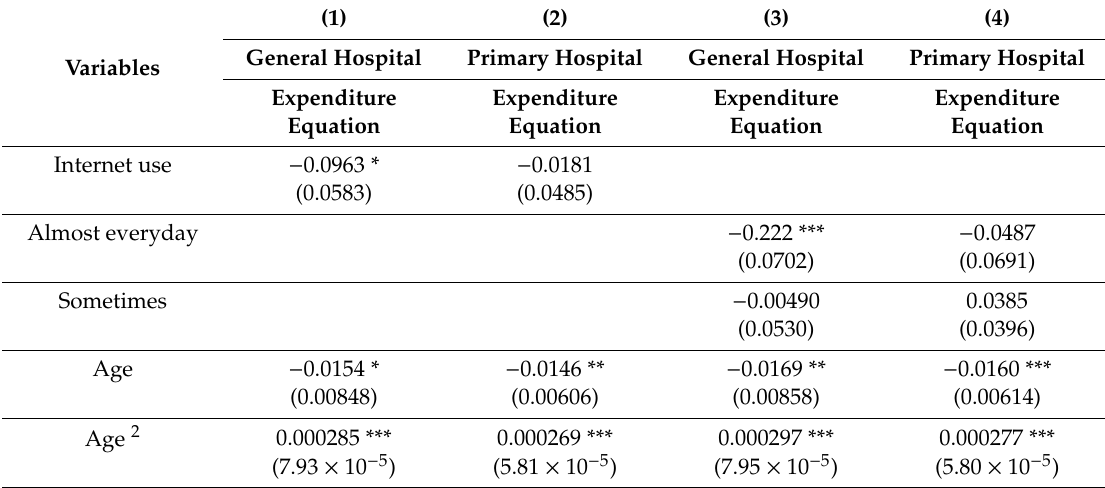
Table 3. Impact of Internet use on individuals’ medical expenditure among di ff erent hospital